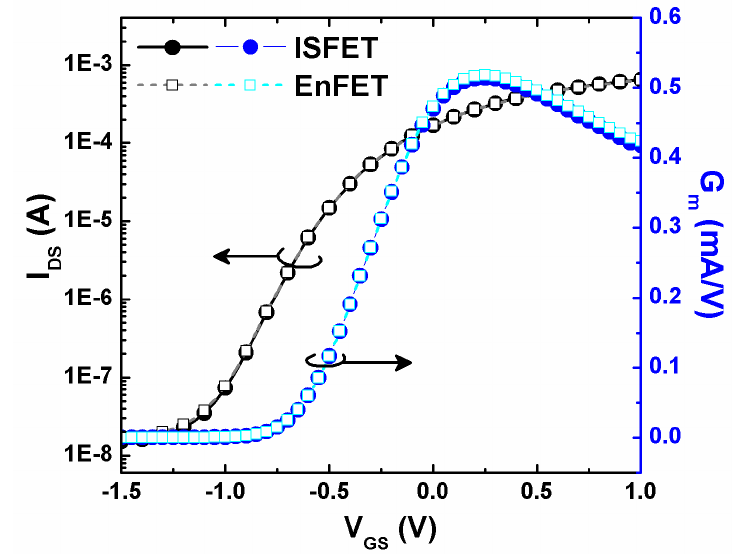
Figure 5. I –V curves and transconductance of ISFET and DS GS